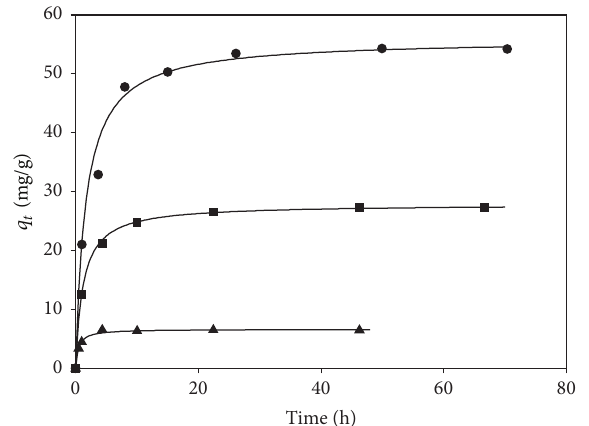
Figure 4: Energy dispersive spectral analysis and mapping (photos) of natural zeolite (medium dash line) compared with Fe-zeolite (solid line). The red points represent the iron distribution in the